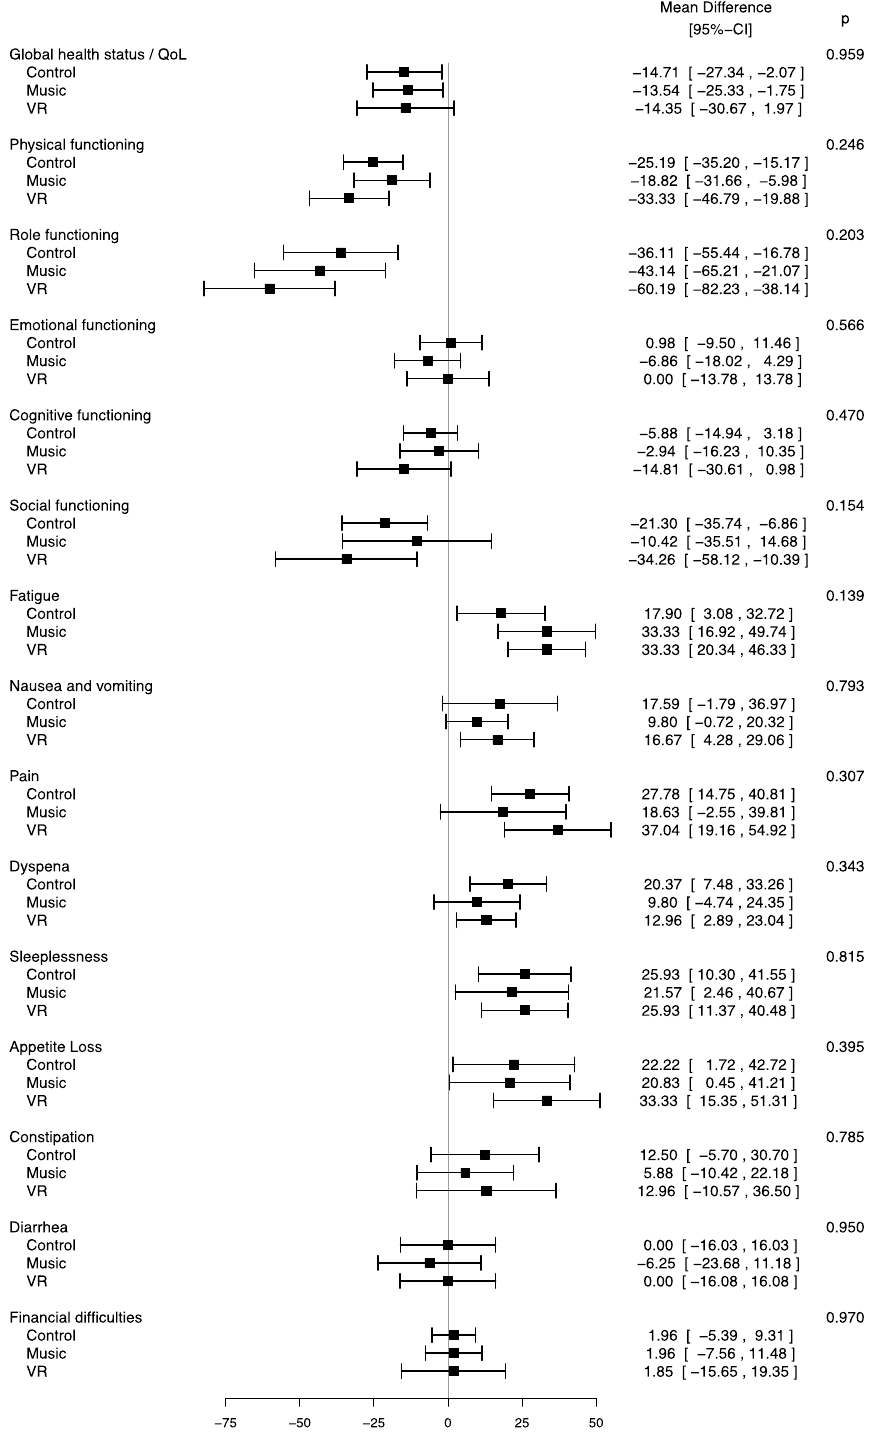
Figure 4. Change in quality of life between admission and discharge (EORTC